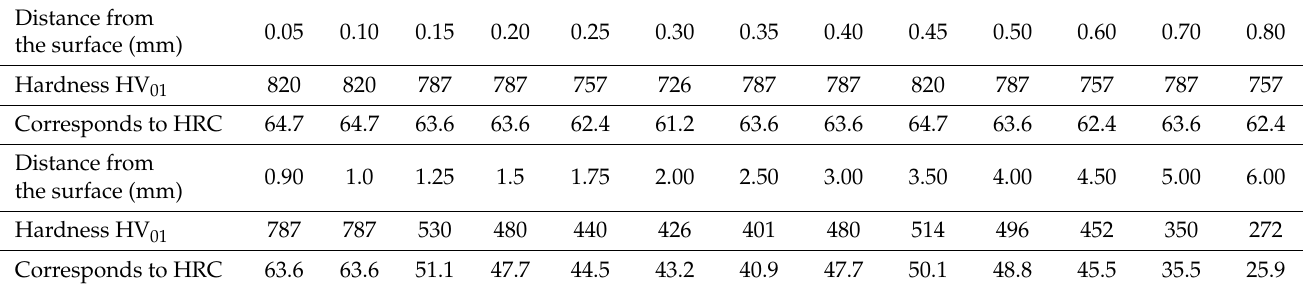
Table 8. Microhardness of the sample hard-faced with the Inox 18/8/6 + EDur 600 filler metals. Distance from the surface (mm)